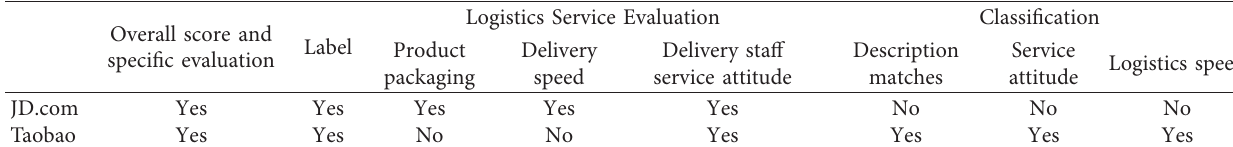
Table 4: Network evaluation models of JD.com and